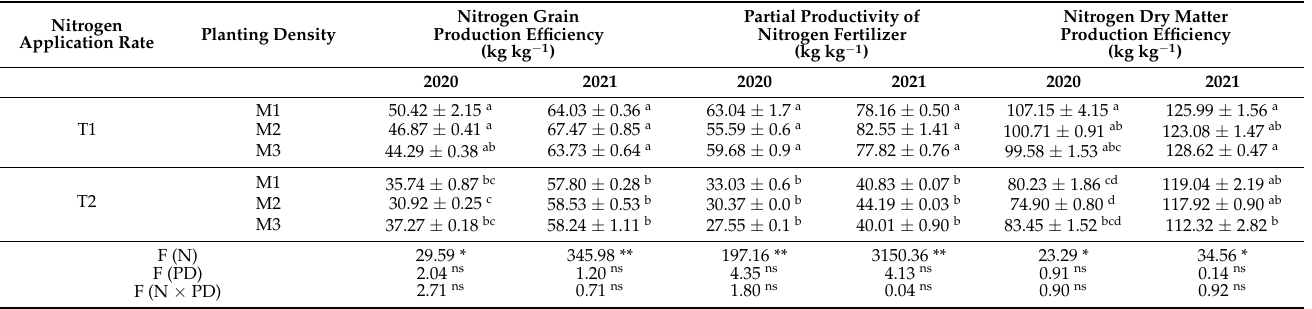
Table 5. Nitrogen grain production efficiency, nitrogen dry matter production efficiency, and nitrogen partial productivity rice under different nitrogen application rates and planting densities.